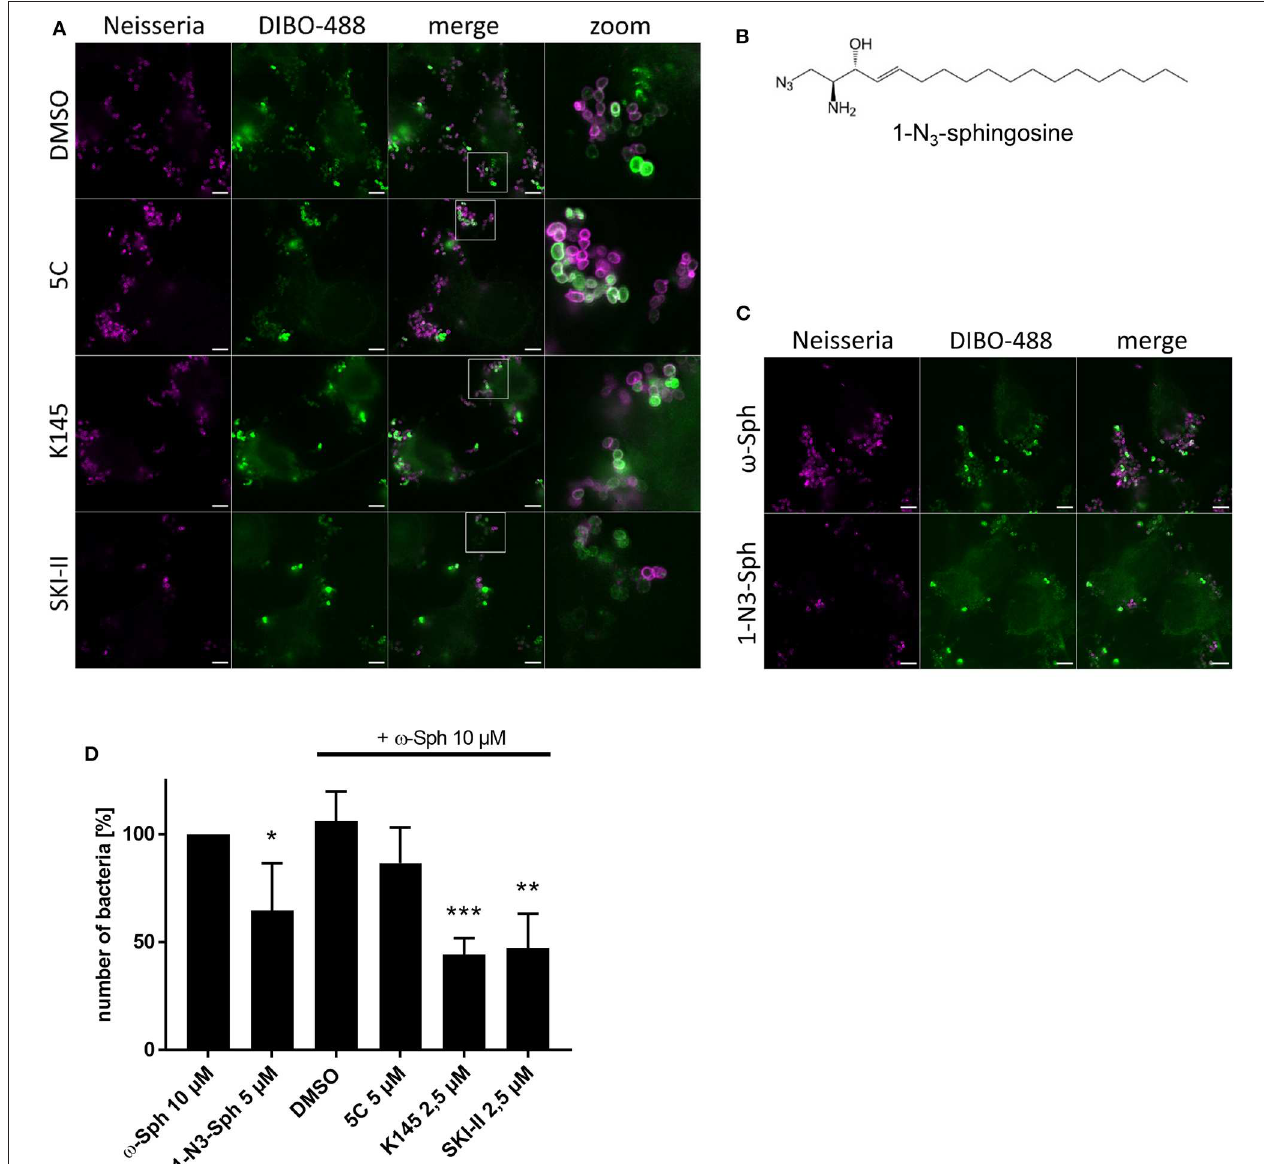
FIGURE 7 | Effect of increased sphingosine concentrations on gonococci (N927) either by inhibition of SphKs (A) or using a sphingosine analog with the azide modification at the phosphorylation position for S1P (B) . (A) Chang cells were pre-treated with SphK inhibitors before addition of ř -N 3 -sphingosine ( ř -Sph). These cells were the infected for 4h and click reaction with DIBO-488 was performed. Gonococci were immunolabeled with anti-gonococcal antibody. (B) Chemical structure of the clickable derivate 1-N 3 -sphingosine (1-N 3 -Sph). (C) Shown are immunofluorescence images of cells treated with ř -Sph or 1-N 3 -Sph after 4h of infection. (D) Quantification of gonococcal survival after 4h of infection. To inhibit the phosphorylation of sphingosine, cells were either pre-treated with SphK inhibitors or fed with 1-N 3 -Sph. A minimum of eight fields viewed per replicate of three independent experiments were counted. Error bars show the mean ± SD of